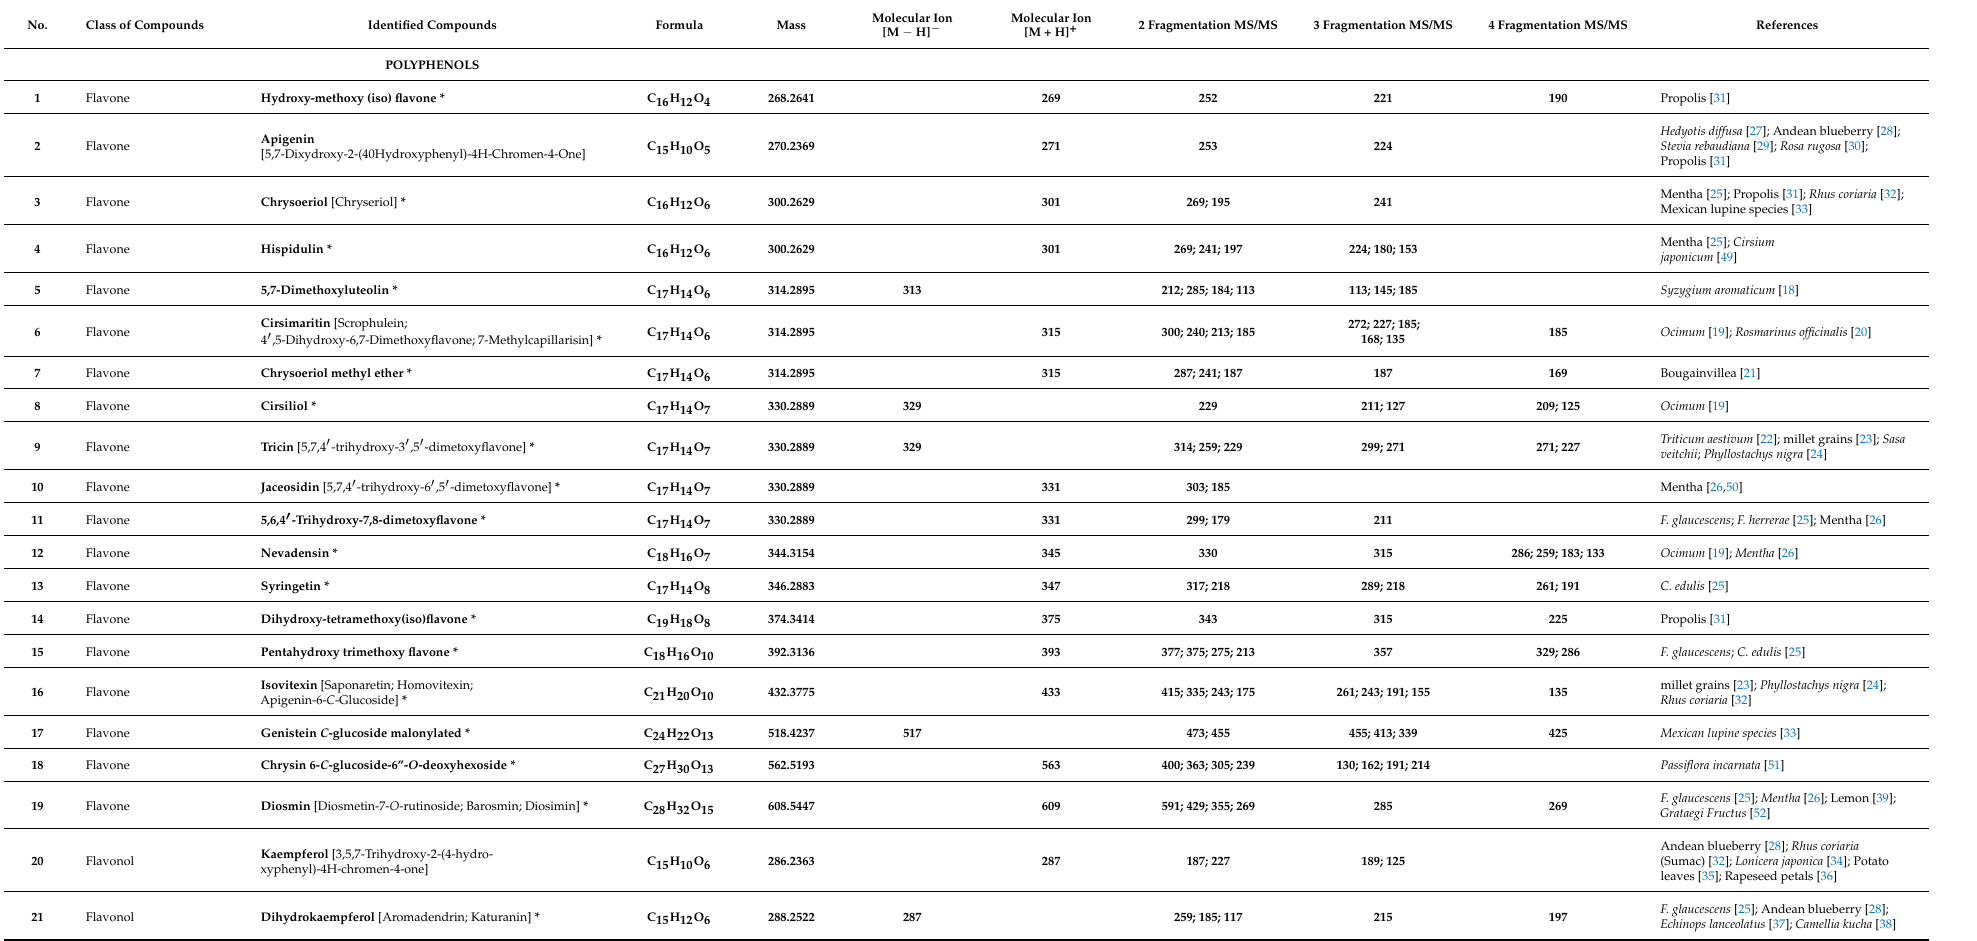
Table A1. Compounds identified from the extracts of Rosa rugosa Thumb., Rosa davurica Pall., and Rosa acicularis Lindl. in positive and negative ionization modes by HPLC–ion